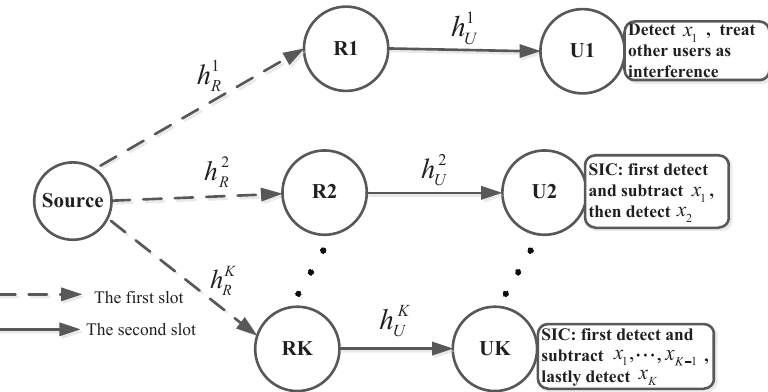
Figure 1. System diagram of the proposed non-orthogonal multiple access (NOMA) relay with simultaneous wireless information and power transfer (SWIPT)